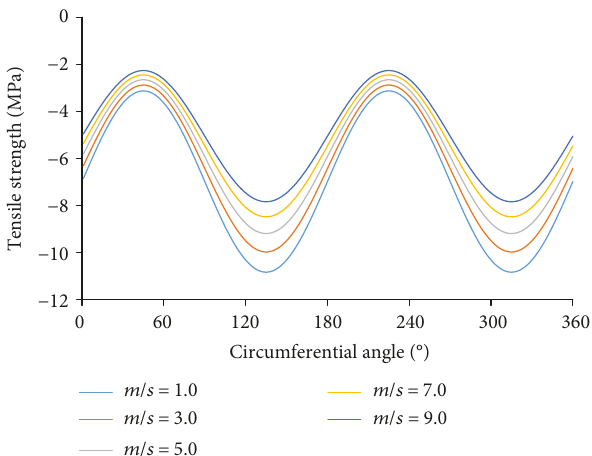
Figure 14: The relationship curves between tensile strength and circumferential angle of di ff erent A / B